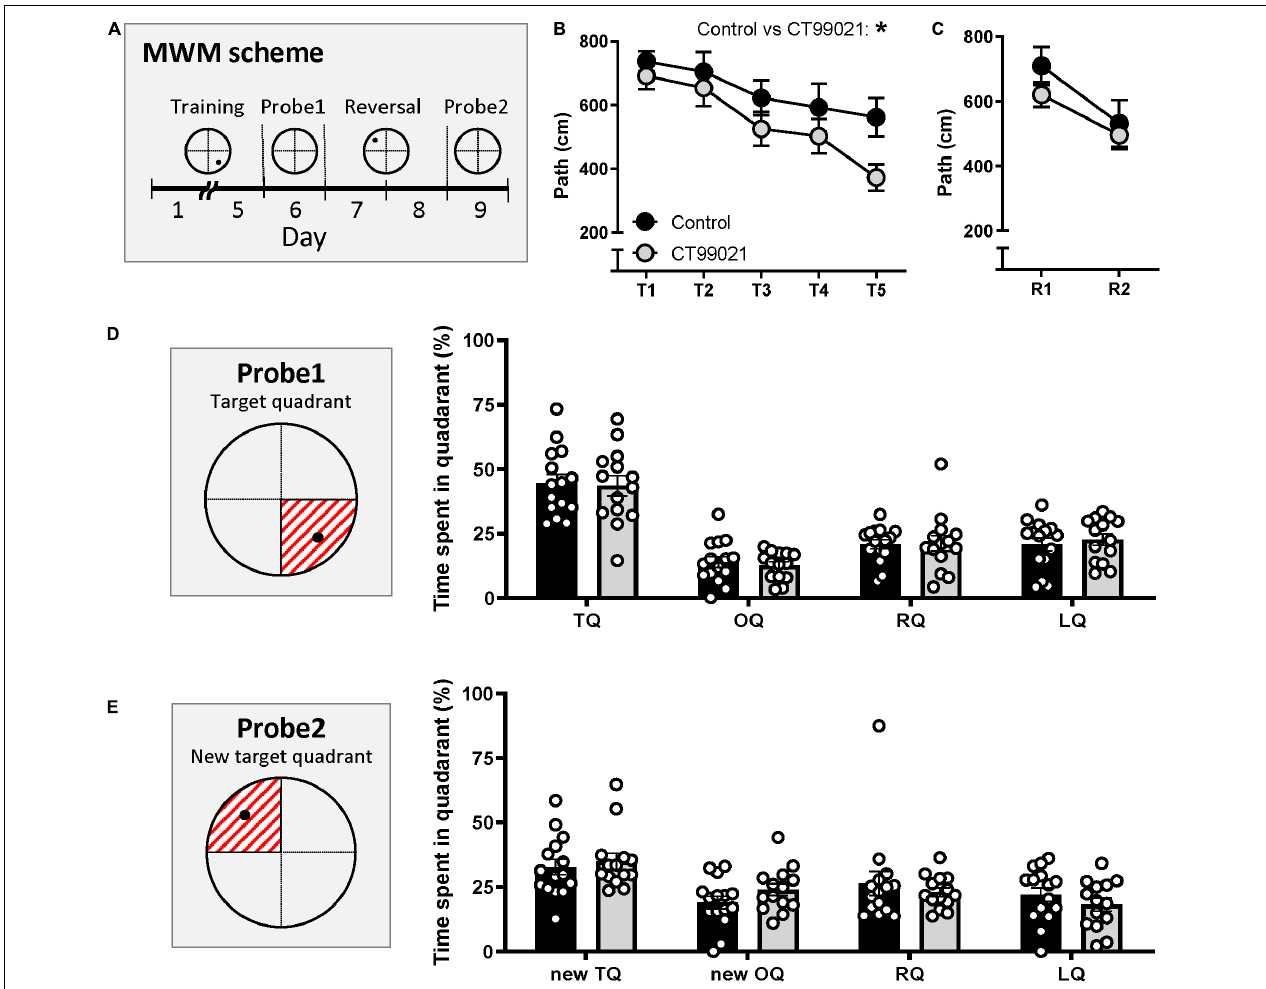
FIGURE 3 | CT99021 improves acquisition in the hidden platform version of the MWM. (A) Schematic drawing of the schedule in the MWM. Black circle represents where the hidden platform was placed. (B) Path length (cm) to the hidden platform is different between vehicle ( n = 15) and CT99021 group ( n = 14) ( ∗ p < 0.05, two-way ANOVA). (C) Path length to the hidden platform during reversal learning is comparable between two groups ( p > 0.05, two-way ANOVA). (D) (Left) Illustration of the target quadrant represented as the red shaded area on probe 1. (Right) Time spent (%) in four quadrants on probe 1 is not different between